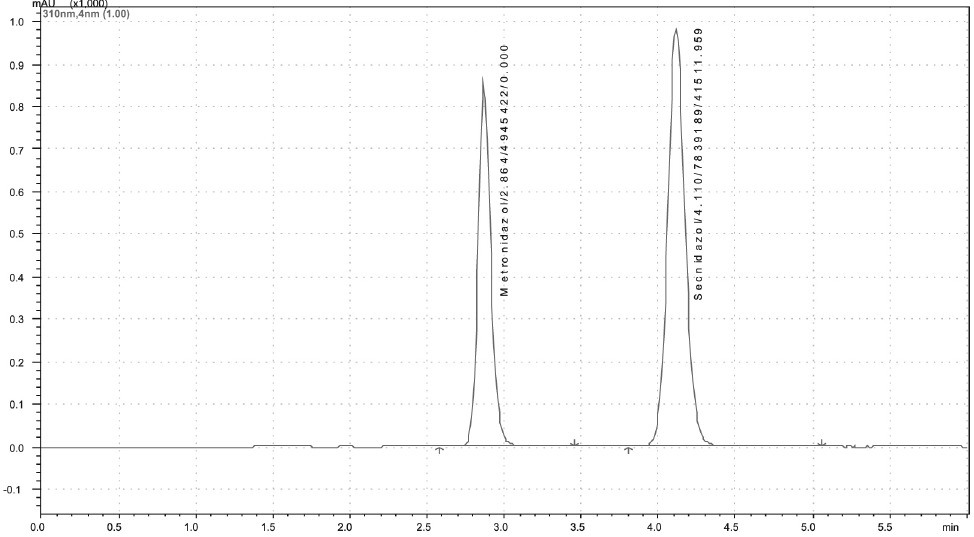
FIGURE 1 - Chromatograph obtained from volunteers after administration of 1000 mg of secnidazole added to the internal standard, with retention times of 2.8 and 4.1 minutes, respectively. Chromatographic conditions: column C 18-Kromasil Akzo-Nobel, 150 mm x 4.6 mm; mobile phase consisted of distilled water and acetonitrile (85:15 v/v) with elution rate of 1 mL/min at a temperature of 40 °C and UV detection of 310